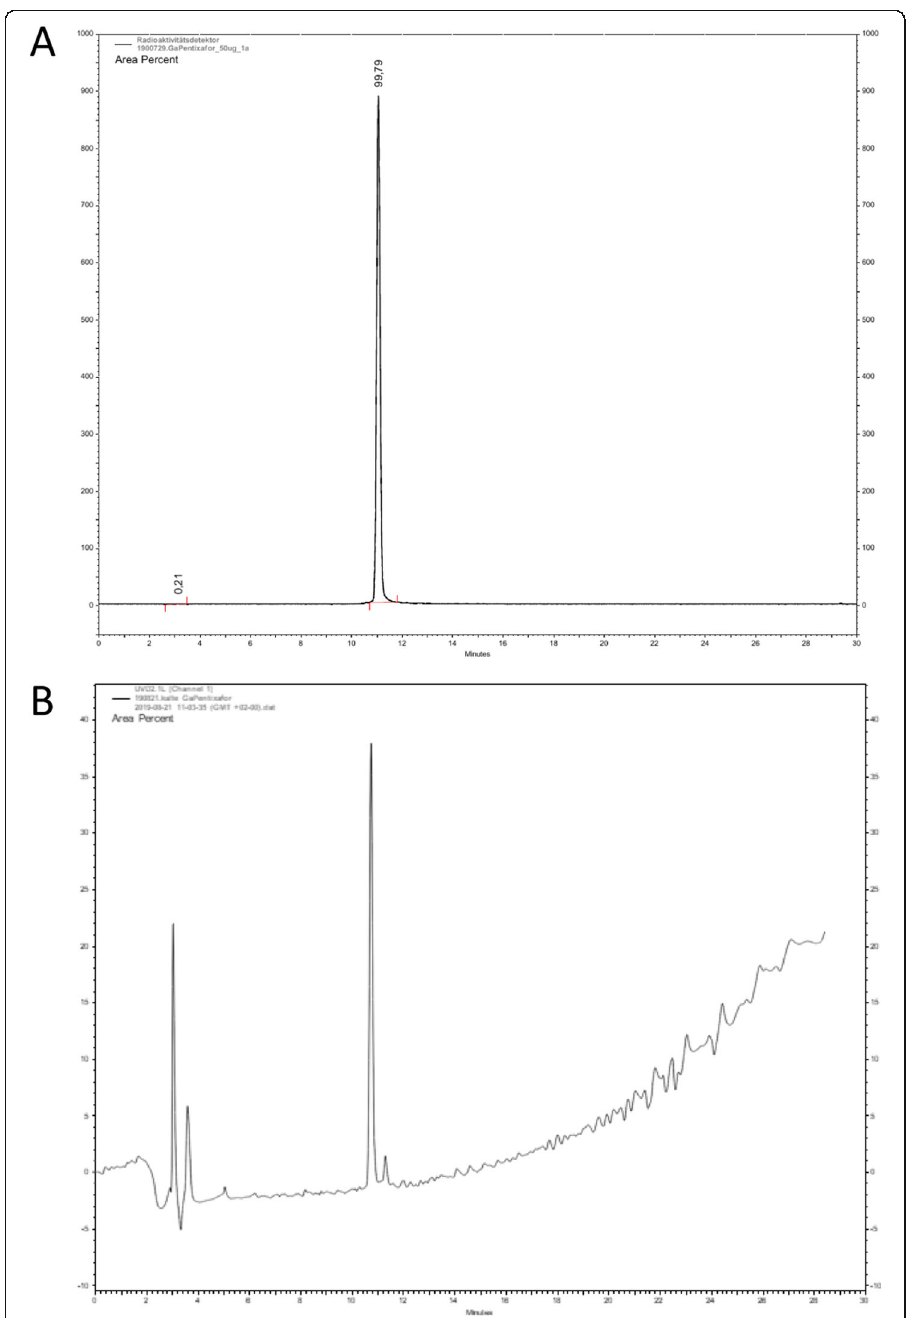
Fig. 3 a Radio-HPLC Chromatogram of [ 68 Ga]Ga-PentixaFor, 50 μ g. b UV-HPLC Chromatogram of [ nat